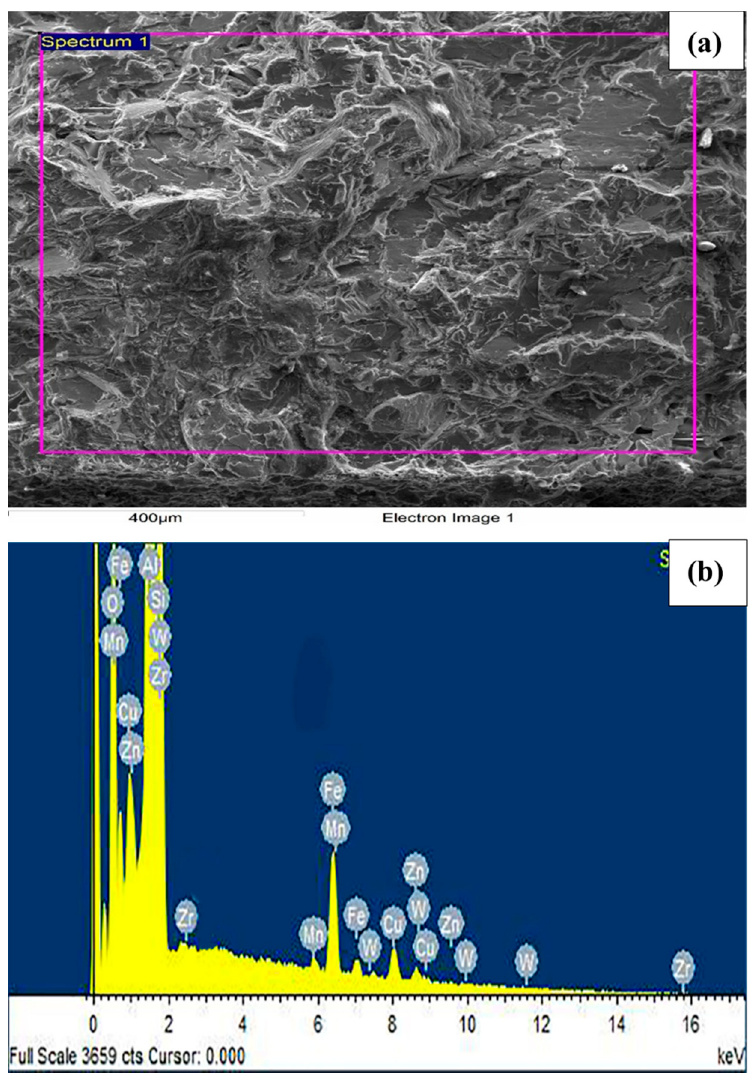
Figure 7. SEM images and EDS spectra show the chemical composition of composite ( a ). Selected spectrum on SEM image of composite ( b ) phases of silicon, manganese, zirconium, tungsten, and other components of A356.